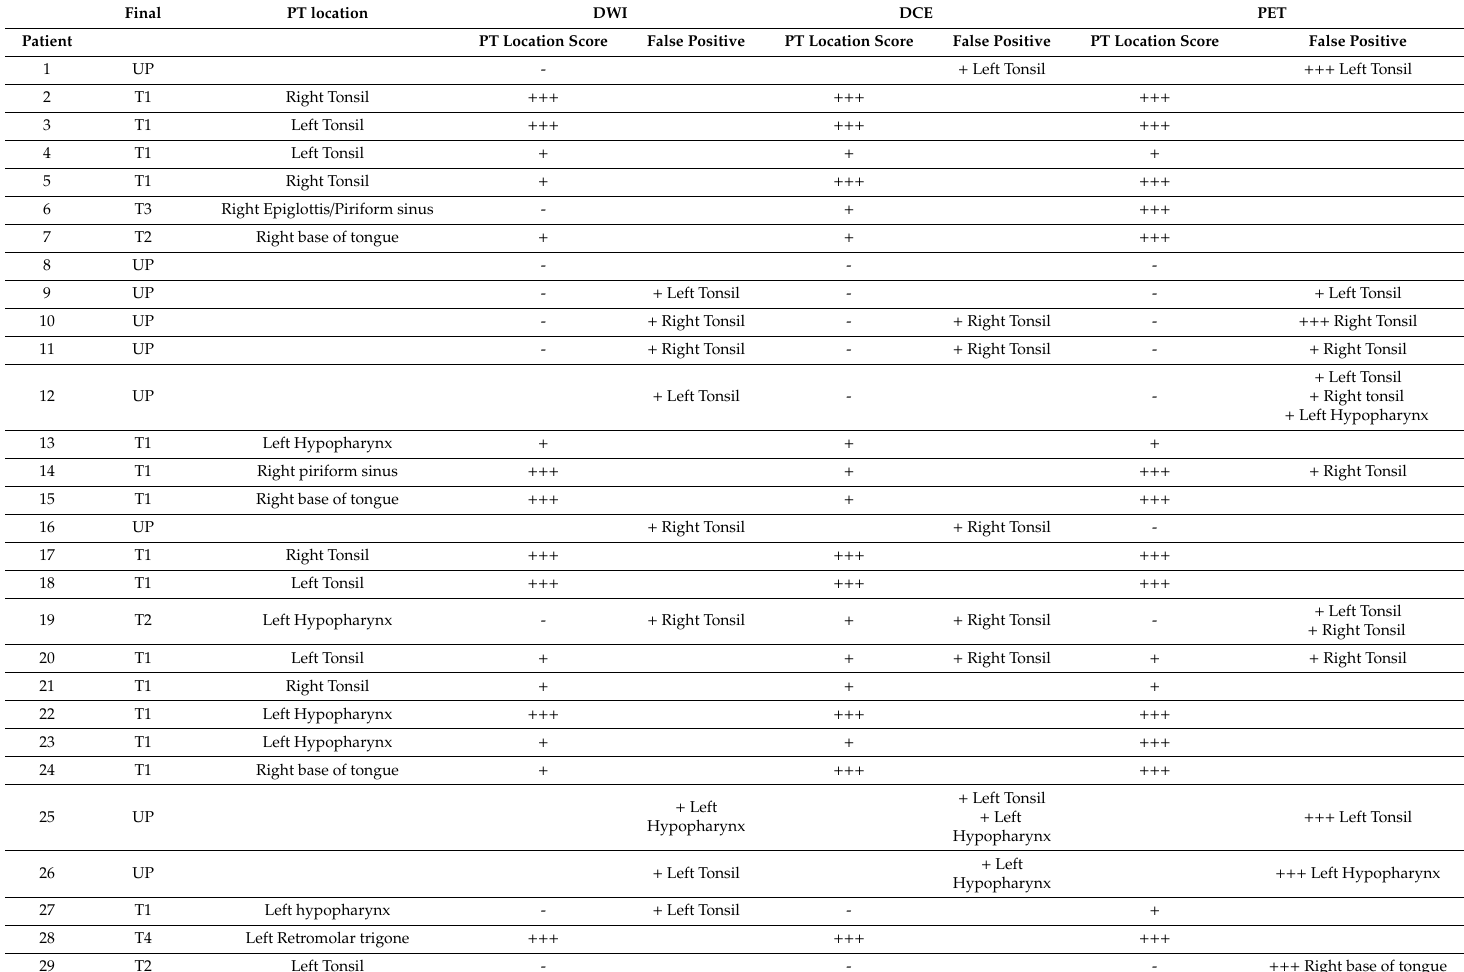
Table 2. The final diagnosis per-patient (T-stage or unknown primary (UP)), tumor location, consensus scores of each modality for primary tumor location and false positive scores. A +++ —score was rated for a malign lesion, a + —score for a probably malign lesion and a —-score for a benign